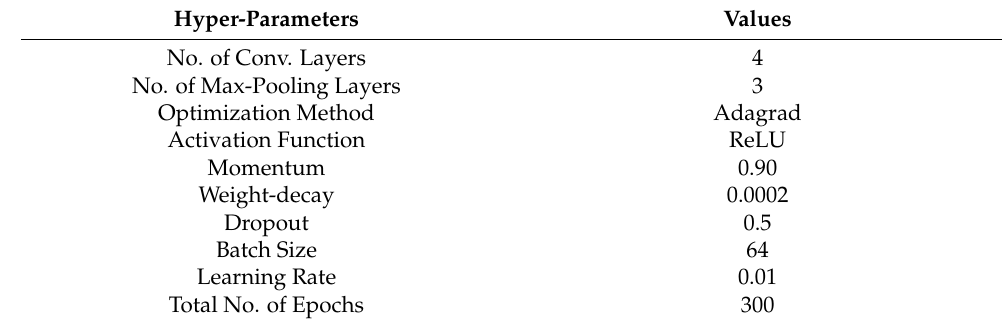
Table 3. The values of the hyper-parameters for the best obtained CNN model for addressing person ReID